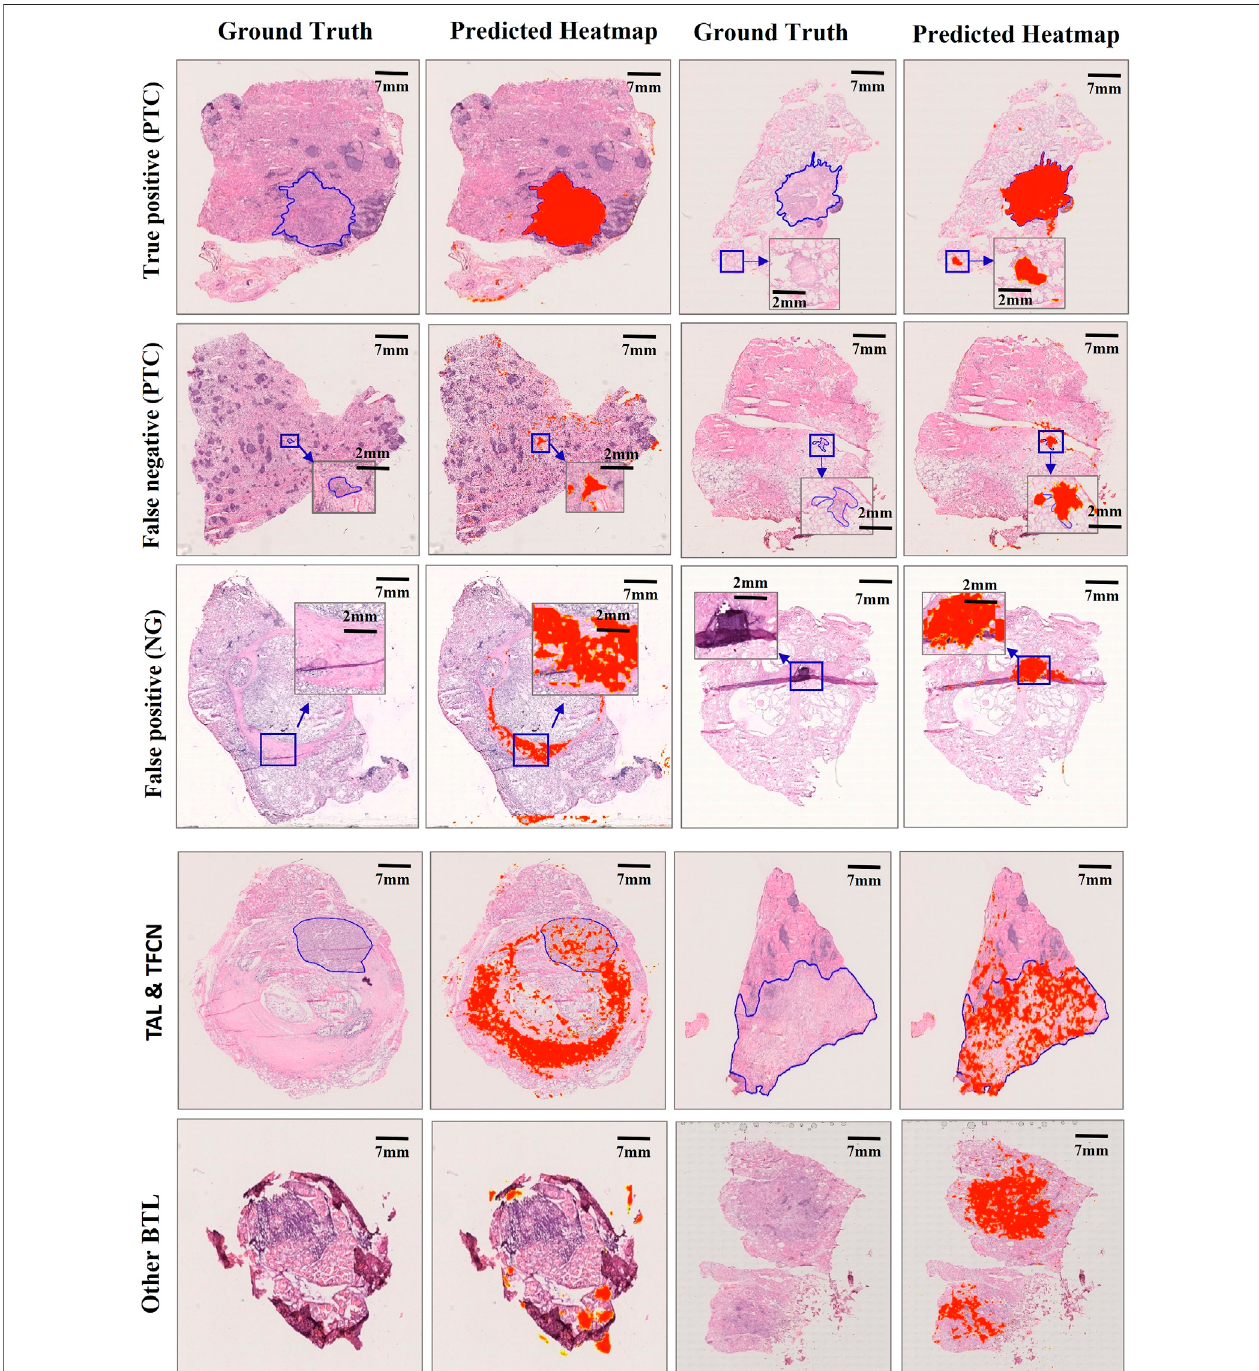
FIGURE3| Misclassi fi cation examples ofselectedslides intheTest 1dataset.Examplesoftruepositive,falsenegative,falsepositive,andothersubtypeslides are represented.Ourmodelperformedef fi cientlyintumorcarcinomasfortruepositives(PTC),butthefalsepositives(NG)weremainlycausedbythe fi brotictissueinboththe normalandcarcinomaregions.Fibrotictissuesometimeshasalargerareaordiameterthancertaincarcinomaregionsforfalsenegatives(PTC).Because fi brotictissueis quite common in thyroid WSIs, the TAL, TFCN, and other BTL slides outside our training slides showed clear differences in structural features from PTC and NG slides, resulting in a heatmap far from the ground truth.